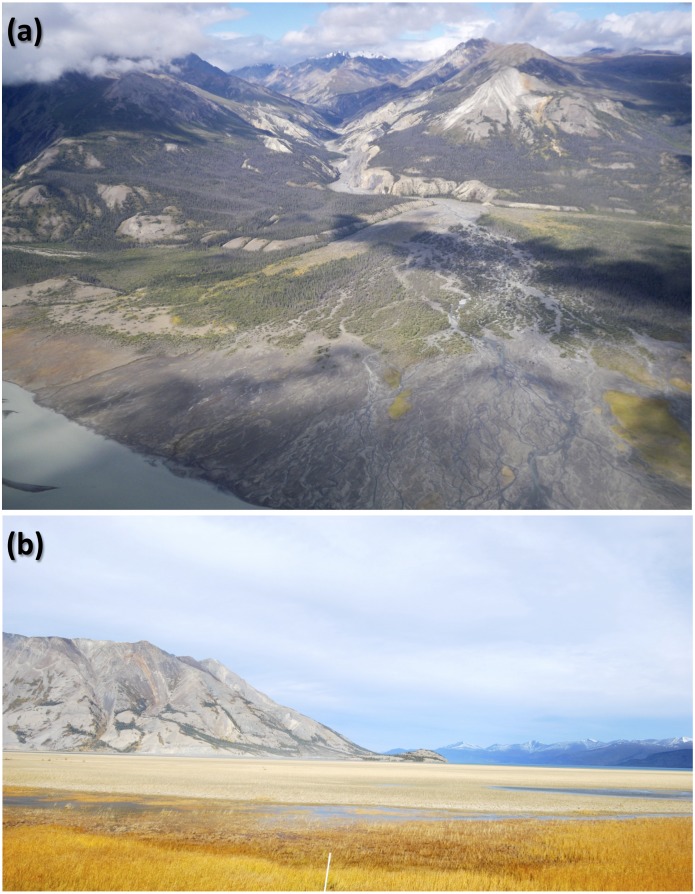
(a) Areal view of the Slims River delta; (b) Slims River vegetation in August.(photographic credits: Fred Longstaffe and Tessa Plint).